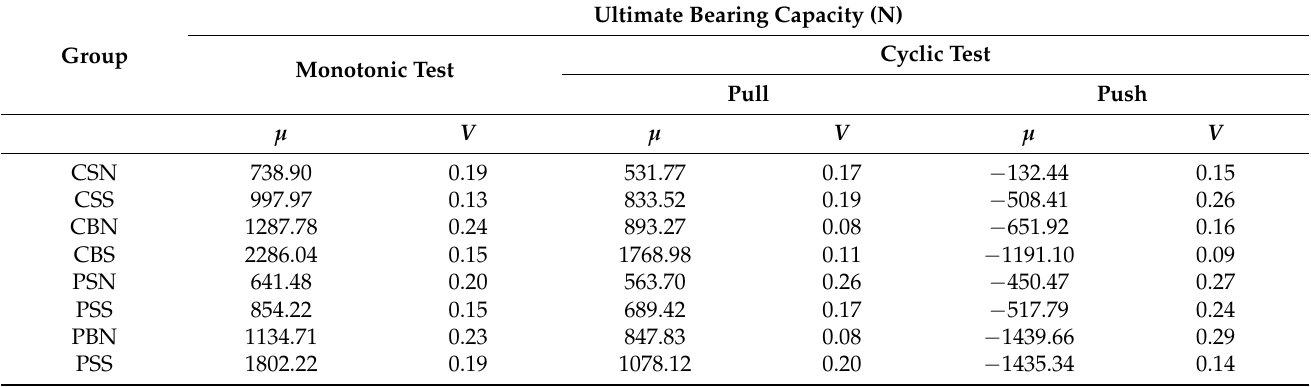
Table 3. Ultimate bearing capacity of